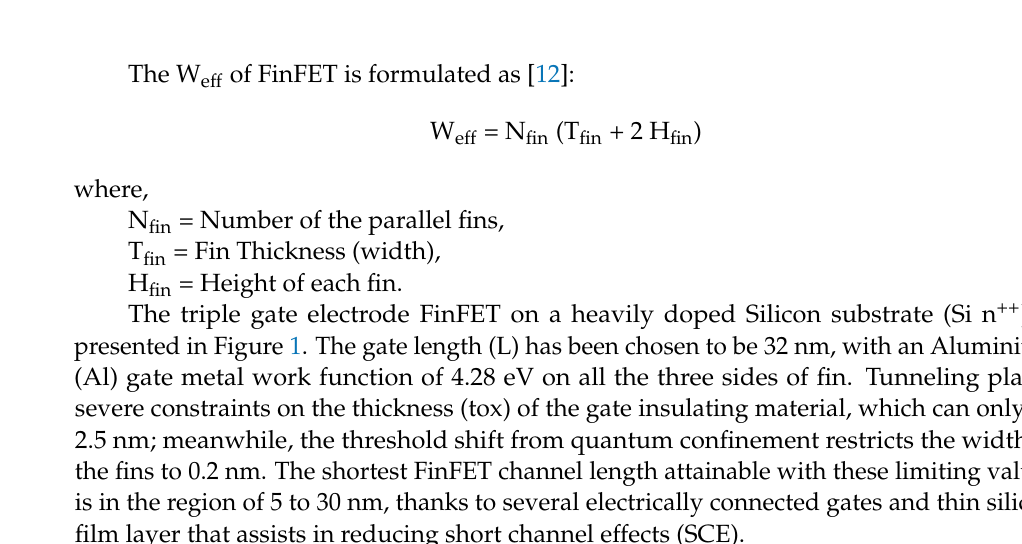
Figure 1. Three ‐ dimensional view of Silicon substrate based FinFET.